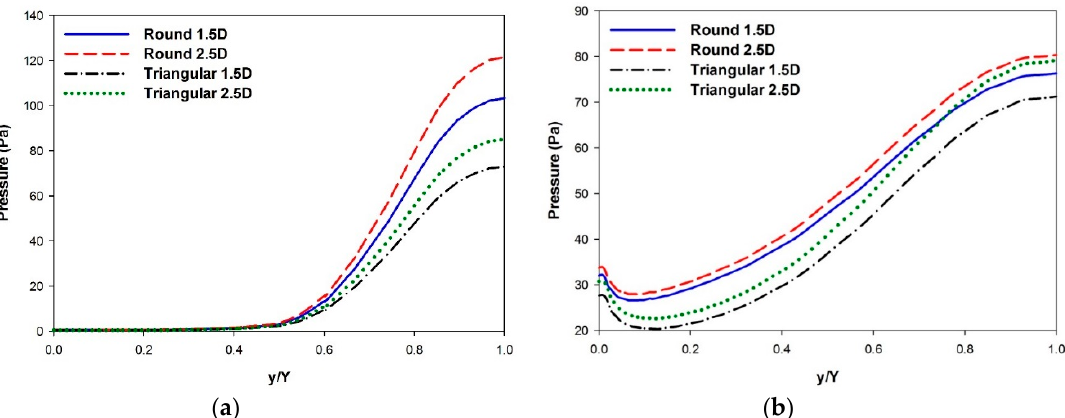
Figure 6. Effect of various duct hole shapes on the pressure distributions at ( a ) point 1 and ( b ) point 2 at an air inlet velocity of 35 m/s and bed slanting angle ( θ ) of 0°.